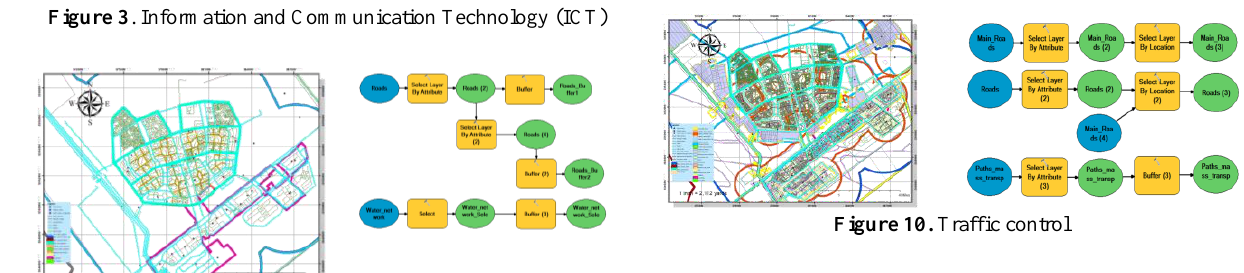
Figure 9. Parking